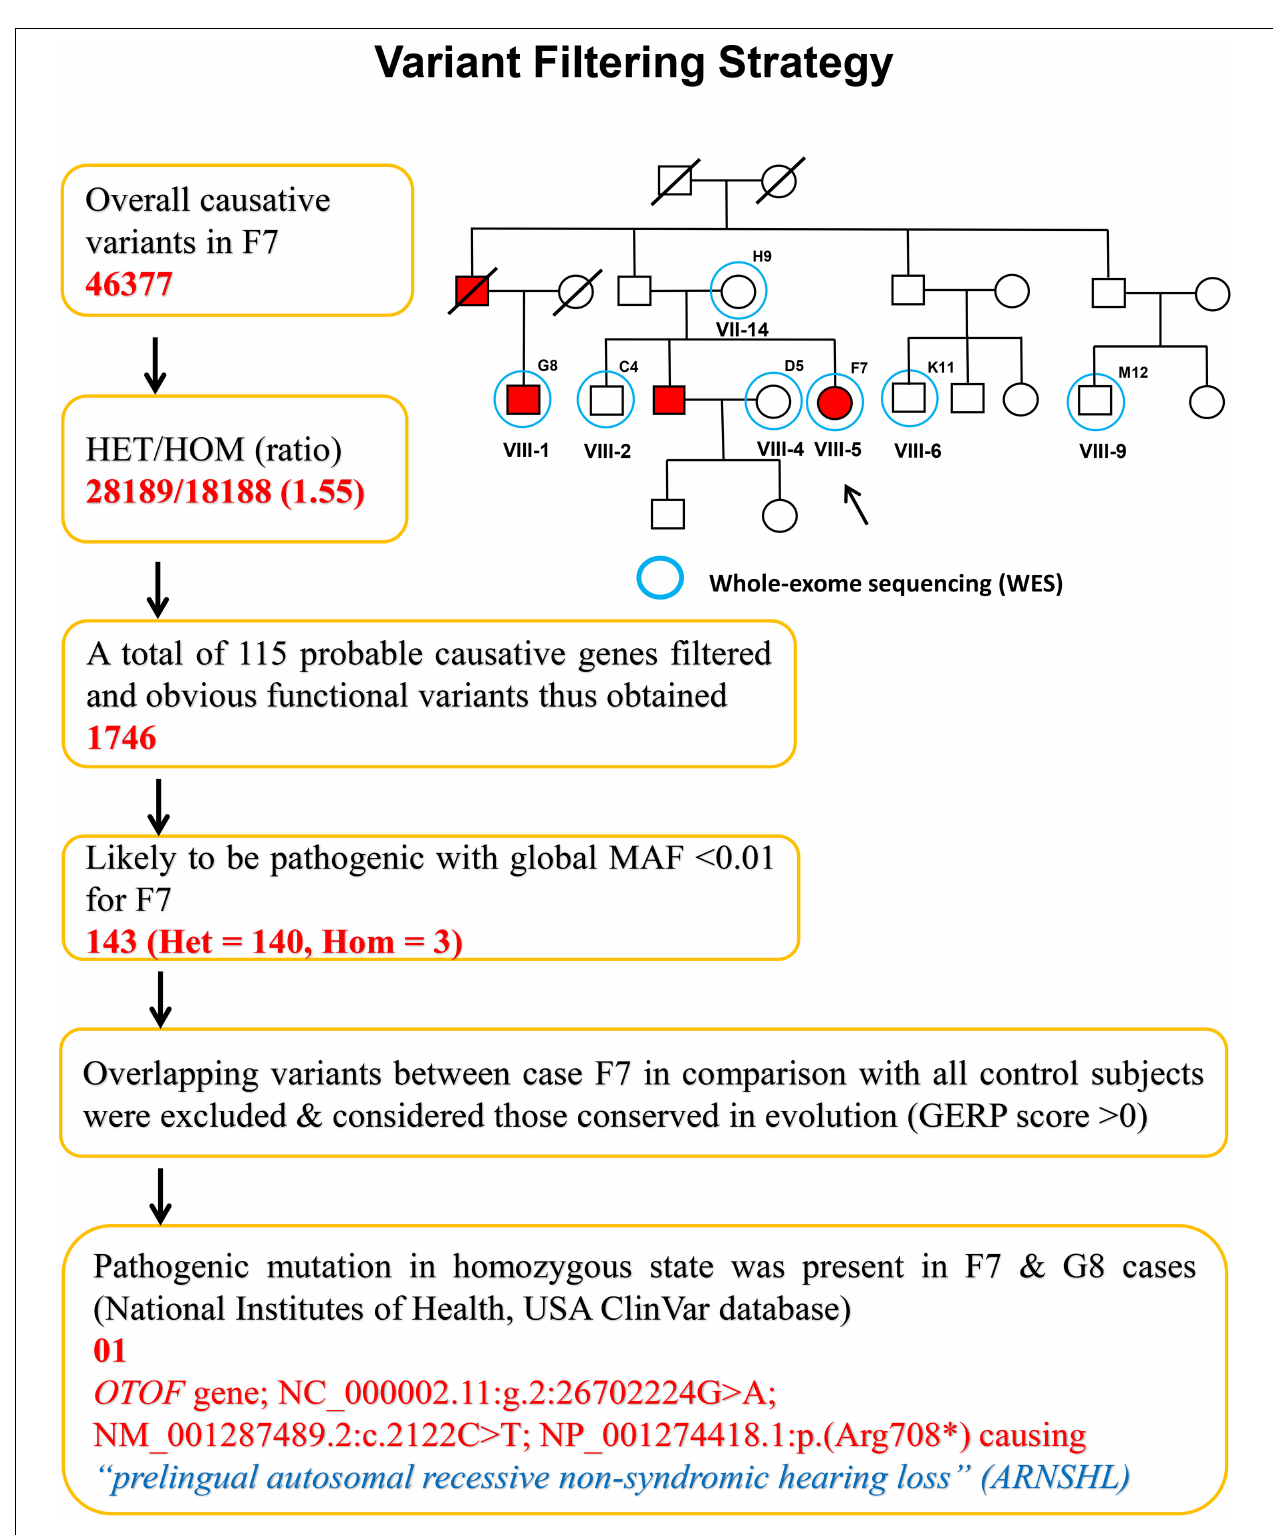
FIGURE 2 | Variant filtering strategy. The narrow down approach applied to whole exome-sequenced samples to explore the most promising causative mutation.